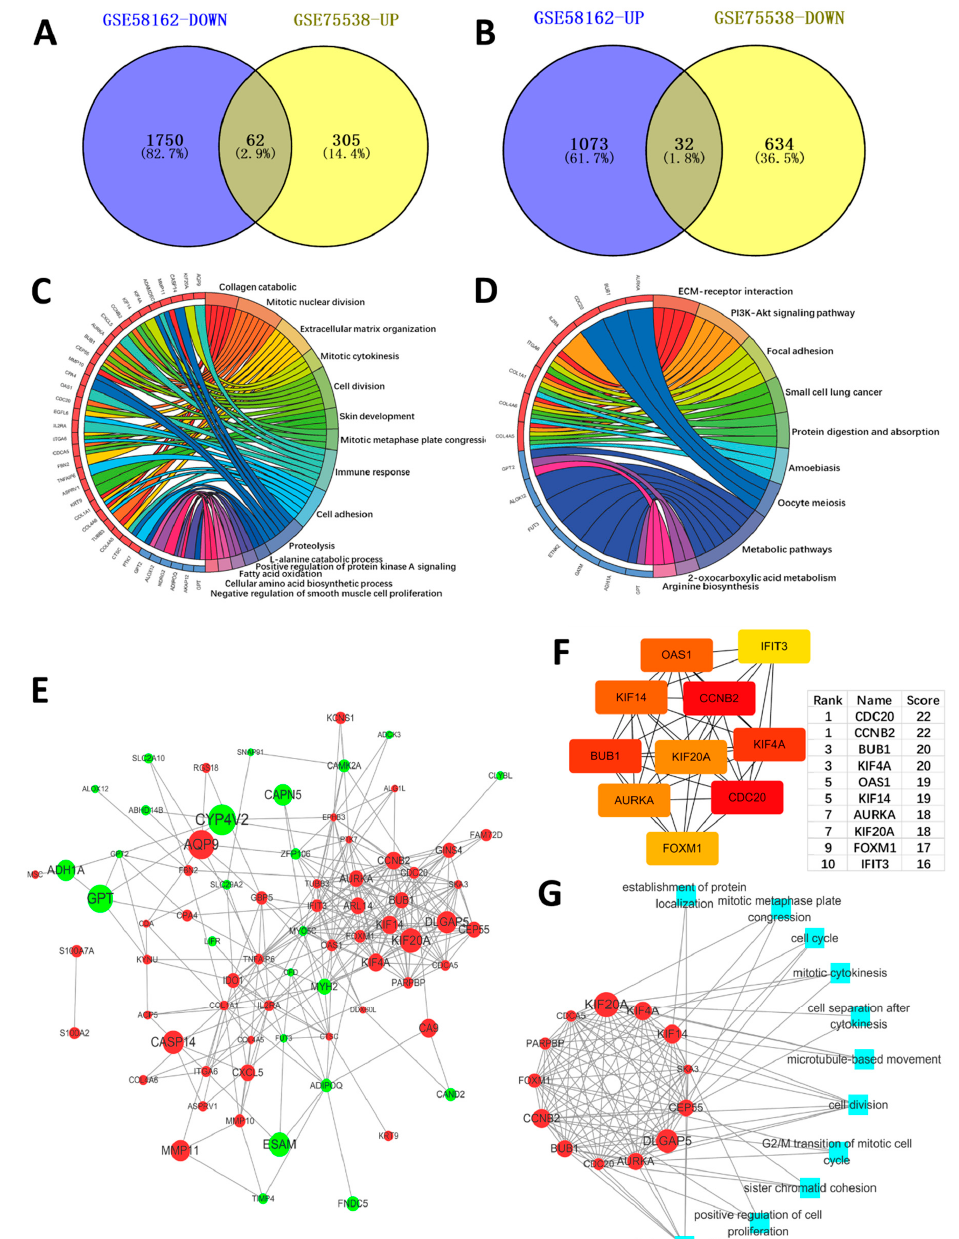
Figure 2. ( A ) The down regulated genes in GSE58162 (genes were down regulated after aspirin treated in OSCC cell line) and the up regulated genes in GSE75538 (genes were high expressed in tumor samples compared with normal samples) were overlapped by the Venn diagram. There outcome was 62 genes, which were highly expressed in OSCC and could be down regulated by aspirin. ( B ) The up regulated genes in GSE58162 and the down regulated genes in GSE75538 were overlapped by the Venn diagram. The outcome showed that there were also 32 genes, which were low expressed in OSCC and could be up regulated by aspirin. ( C ) GO enrichment analysis of the overlapped 62 and 32 genes (biologic process). ( D ) KEGG pathway analysis of the overlapped 62 and 32 genes. ( E ) The protein–protein interaction (PPI) network of the overlapped genes. The red represented the high expressed genes in OSCC, which were down regulated by aspirin, and the green represented the low expressed genes in OSCC, which were up regulated by aspirin. The node size represented |logFC|. ( F ) The top 10 hub genes in the network, which were ranked by node degree. ( G ) The core module of the network and its